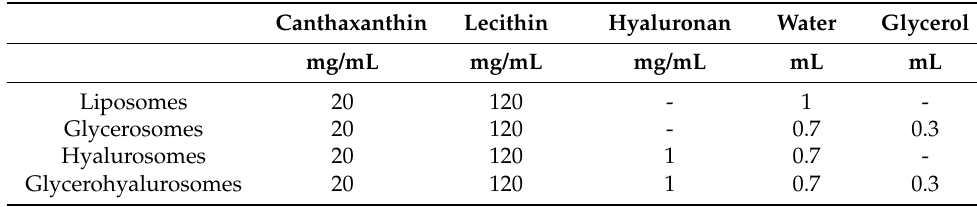
Table 1. Composition of